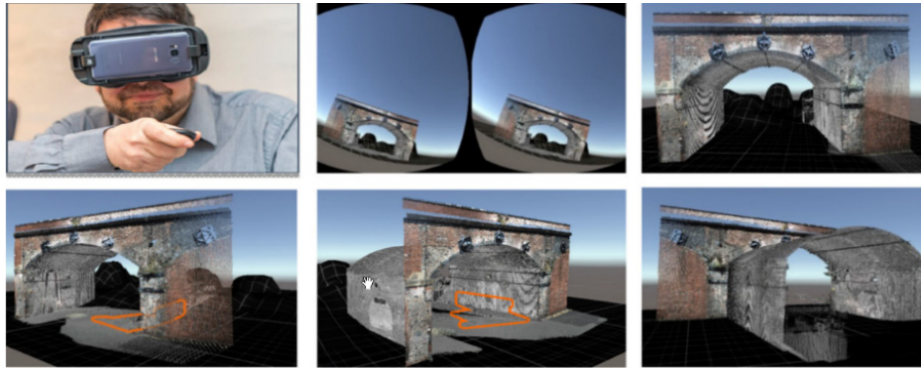
Figure 10. Inspection of a bridge 3D representation in a virtual environment [79].